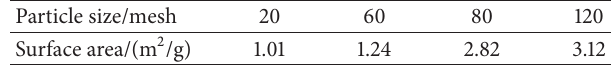
Table 1: BET-N 2 specific surface area of walnut shell (WS) particles with different sizes.